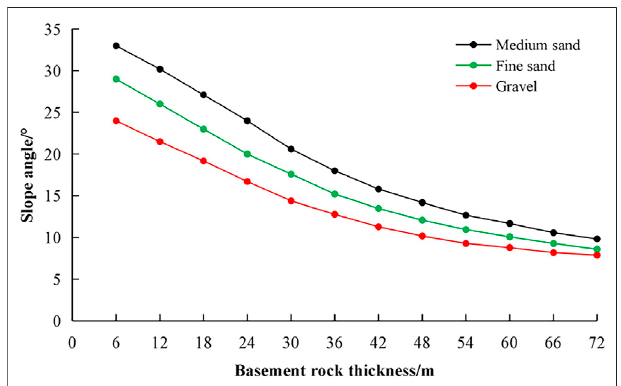
FIGURE 6 | Relationship between base strata thickness and dump slope